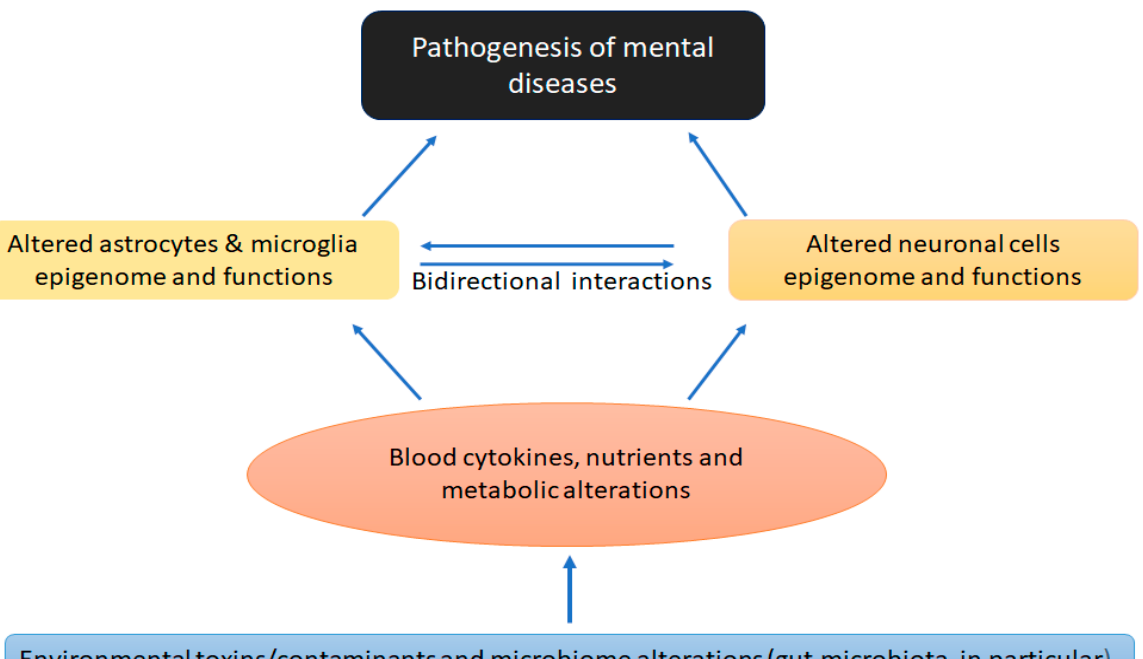
Figure 4. Environmental impacts on the microbiome and the known mechanisms through which brain functions are affected. As illustrated, microbiome alterations not only affect blood inflamma- tory cytokines, which in turn affect brain cell epigenome and functions (see Table 1), but they also affect gut and blood nutrients and metabolites. These then influence neuronal and non-neuronal cells’ epigenetic landscape and functions, leading to disease pathogenies.